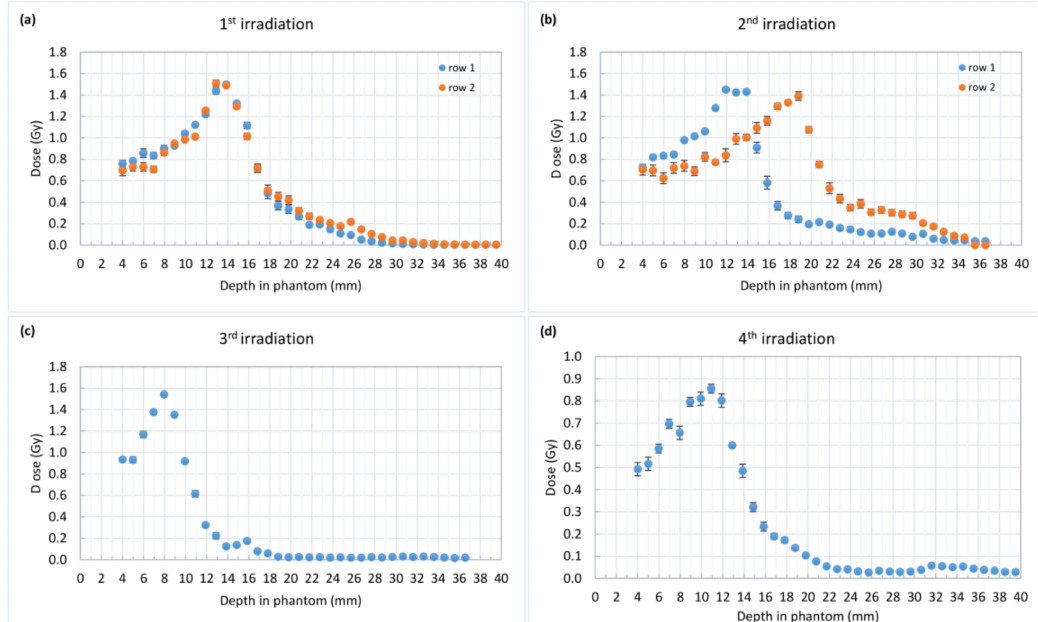
Figure 2. Depth–dose profiles of the proton beam in a bio-phantom provided by the thermoluminescent dosimeters (TLDs-100): ( a ) first irradiation stage: two TLDs’ rows irradiated simultaneously; ( b ) second irradiation stage: two TLDs’ rows irradiated one at time, the second one with a planned energy shift; ( c , d ) third and fourth irradiation stages: one TLD’s row irradiated at different Bragg peak dose.